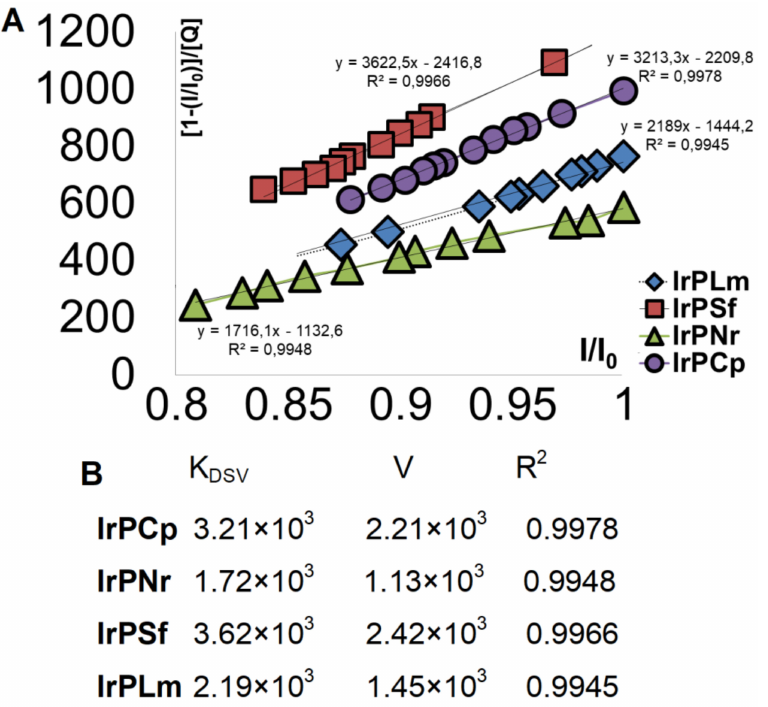
Figure 3. ( A ) Stern–Volmer plots of the CT DNA–DAPI (binding to a minor groove) system quenched by IrPCp , IrPLm , IrPNr , IrPSf ; ( B ) determined K DSV (dynamic quenching constant) values for the studied Ir(III)